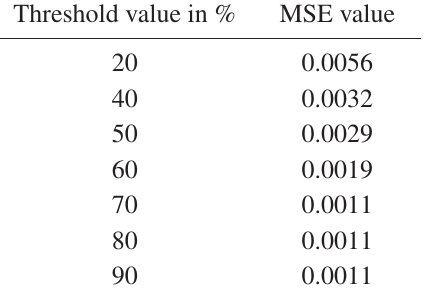
Table 1. MSE value for different threshold.